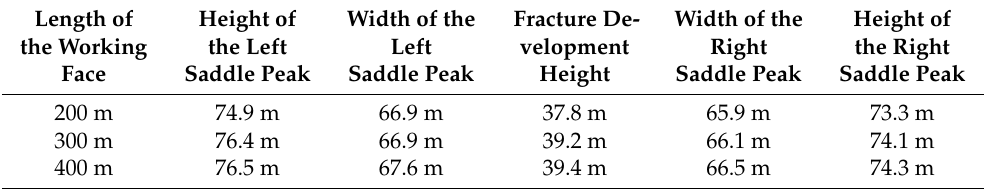
Figure 5. Stratum parameters and loading conditions. Note: L: lithology; B: burial depth; Th: thickness; V: Volumetric force; Ts: tensile strength; M: modulus of elasticity; C: compressive strength; qn/kPa: load on rock stratum. Table 1. Fracture development at different lengths of the working